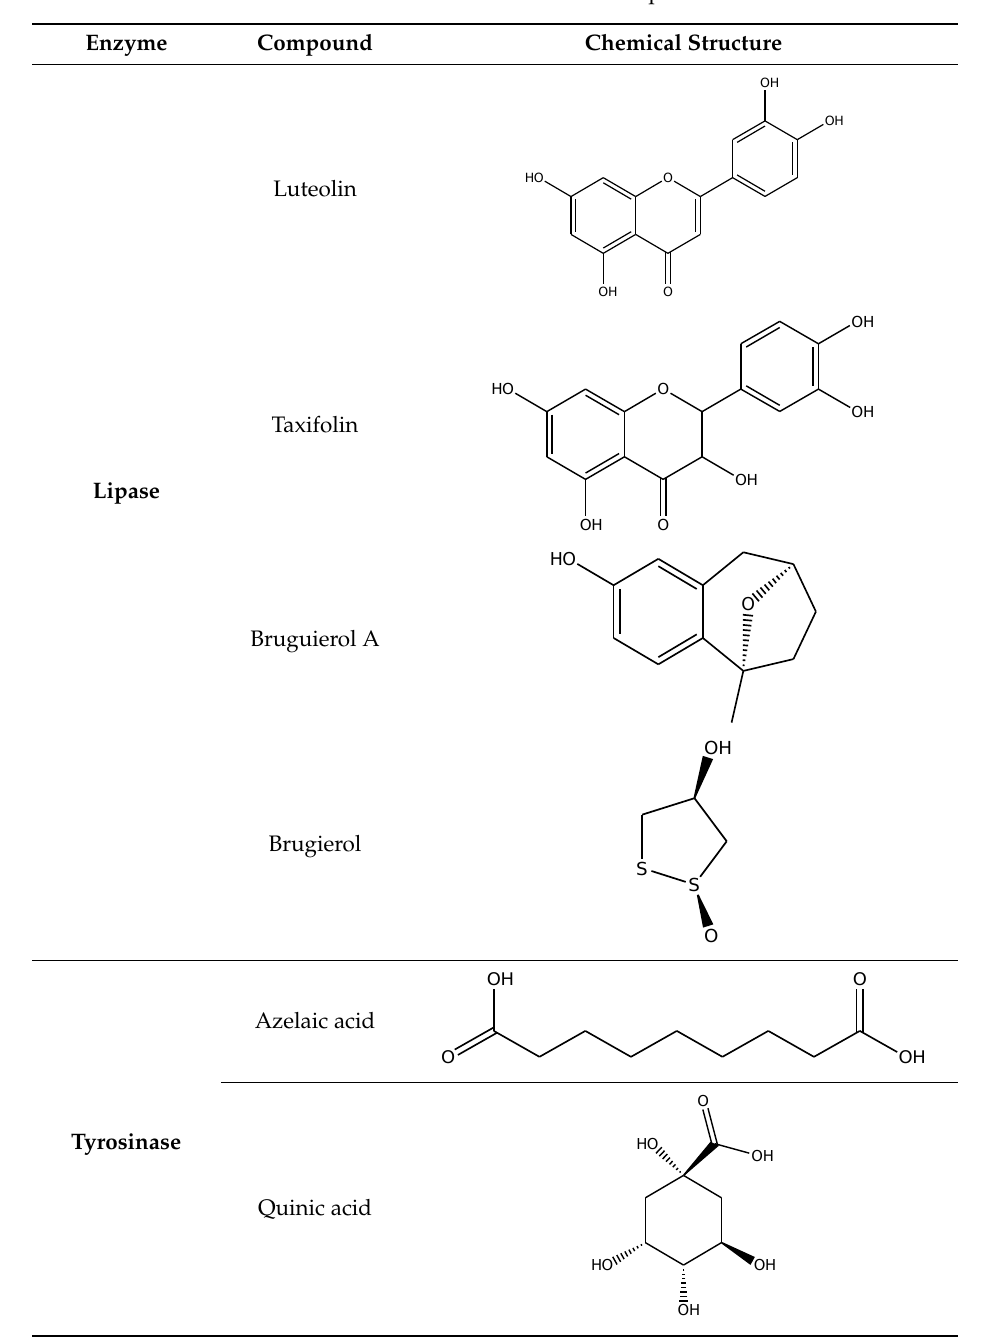
Table 8. Selected docked bioactive compounds.